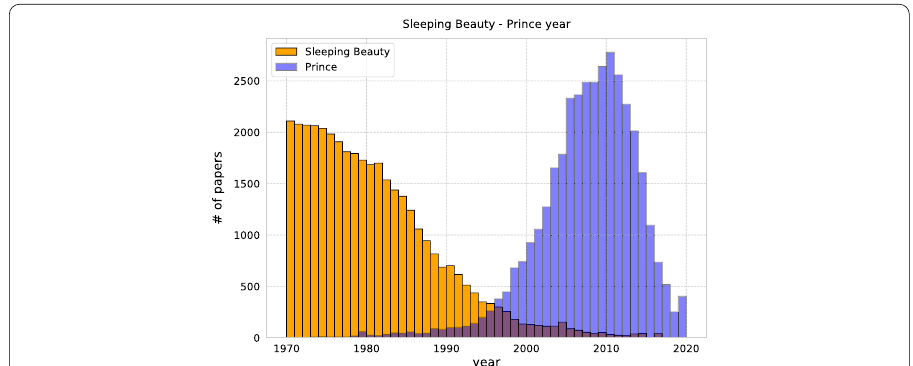
Fig. 9 Publication year of SB and PR extracted in 2020. The orange bars show the distribution of submission years for SB, and the blue bars show the distribution of submission years for